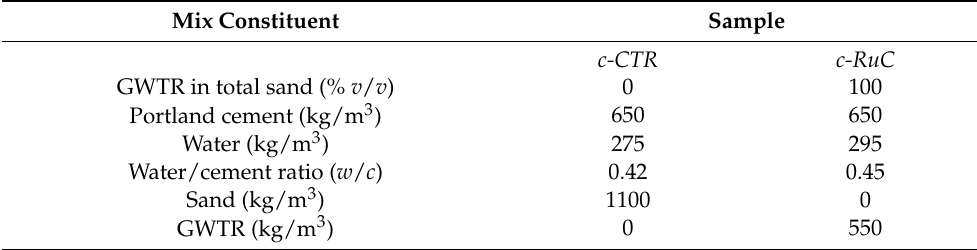
Table 3. Mix proportions of mold-casted formulations: c-CTR and c-RuC .